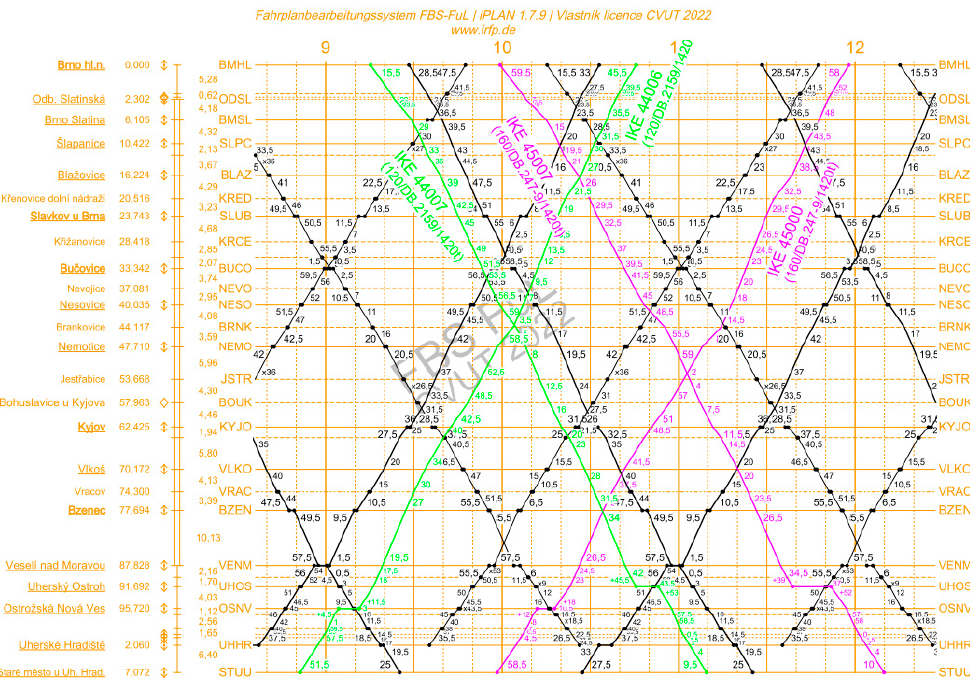
Figure 8. Proposed freight train paths on the rail line 340 (data: [1,28]). Source: Authors.